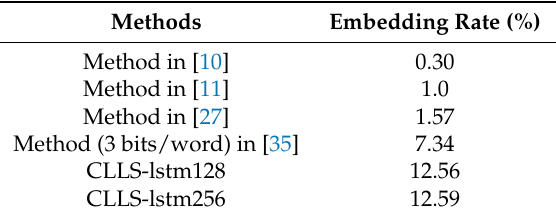
Table 5. The comparison of the embedding